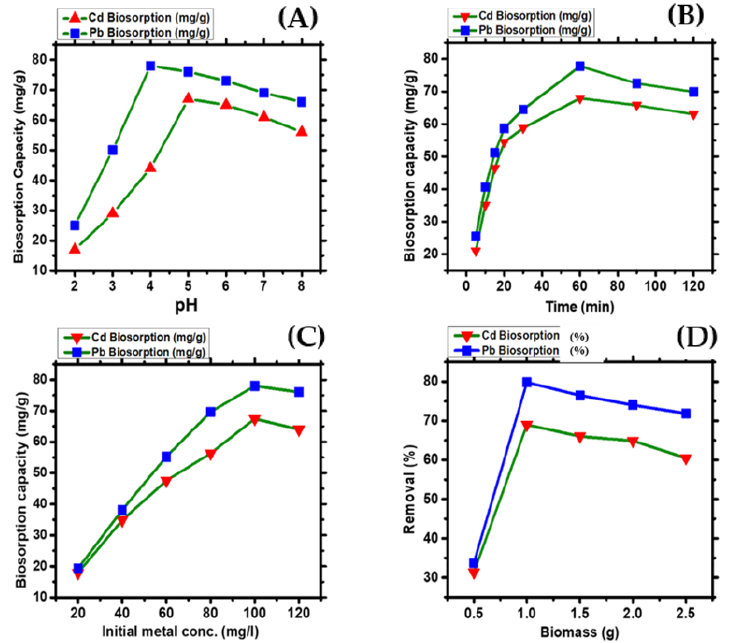
Figure 4. ( A ) Effect of pH, ( B ) contact time, ( C ) initial metal concentrations, ( D ) biomass dosage on the biosorption of Cd and Pb ions.